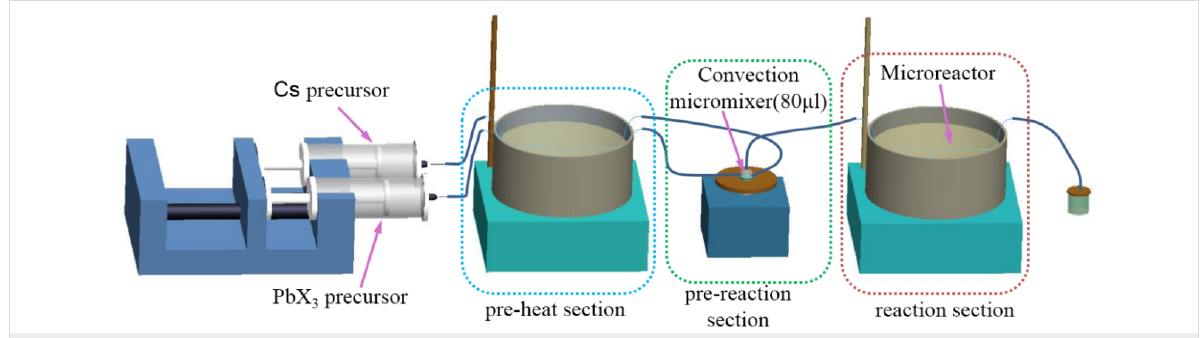
Figure 7: Schematic diagram of a PTFE-based microreactor